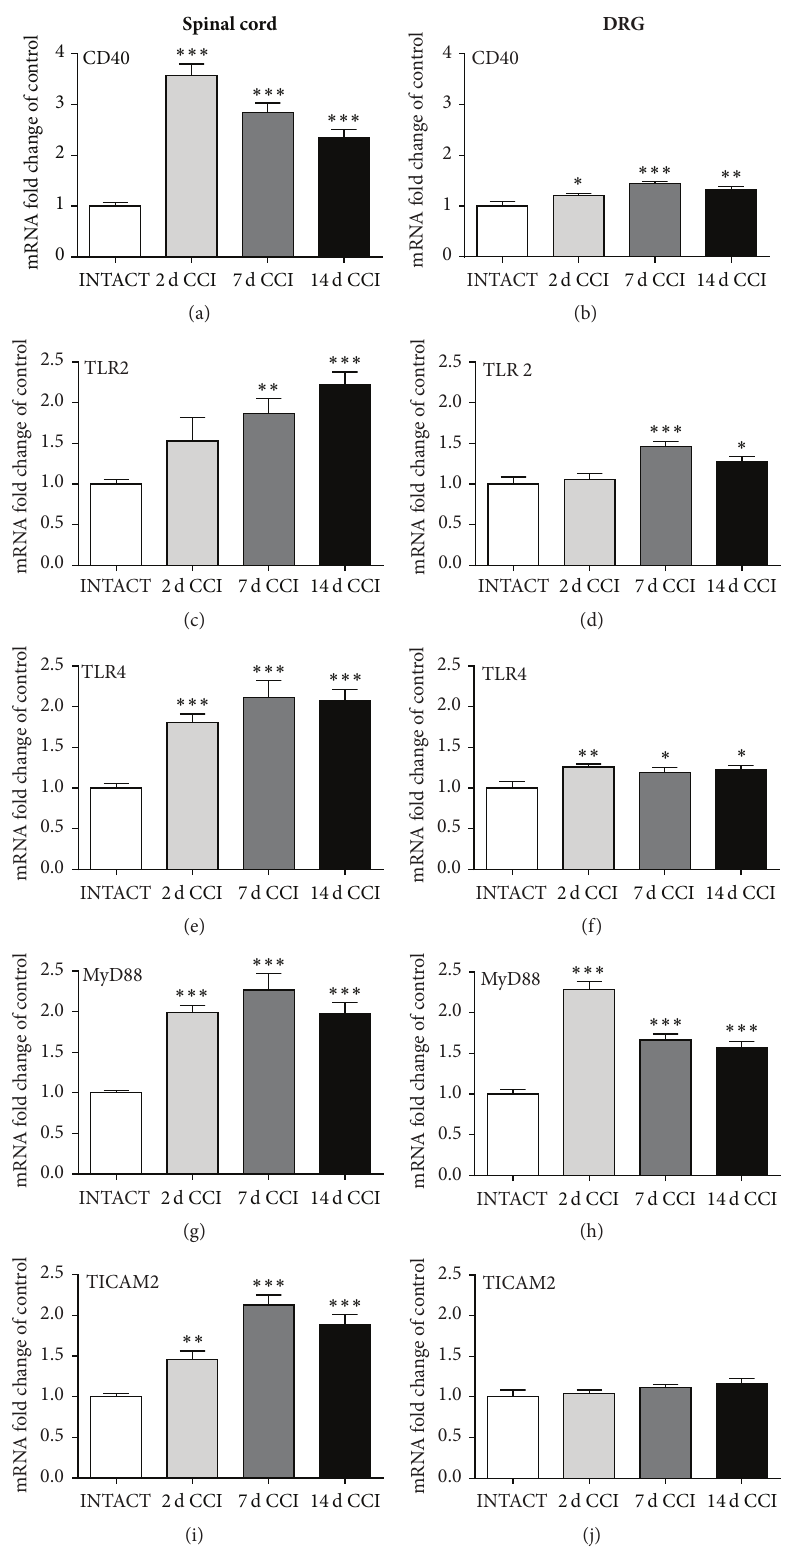
Figure 2: Quantitative real-time PCR analysis of CD40 (a, b), TLR2 (c, d), TLR4 (e, f), MyD88 (g, h), and TICAM2 (i, j) mRNA levels in the ipsilateral dorsal lumbar spinal cord (a, c, e, g, and i) and DRG (b, d, f, h, and j) tissue on 2nd, 7th, and 14th days after chronic constriction injury (CCI) in rats. The data are presented as the mean ± SEM, which represent normalized averages derived from the threshold cycles obtained in qRT-PCR from 6–8 samples per group. Intergroup differences were analyzed using one-way ANOVA followed by Bonferroni’s multiple comparisons test. ∗ 𝑝 < 0.05 , ∗∗ 𝑝 < 0.01 , and ∗∗∗ 𝑝 < 0.001 indicate significant differences versus the INTACT